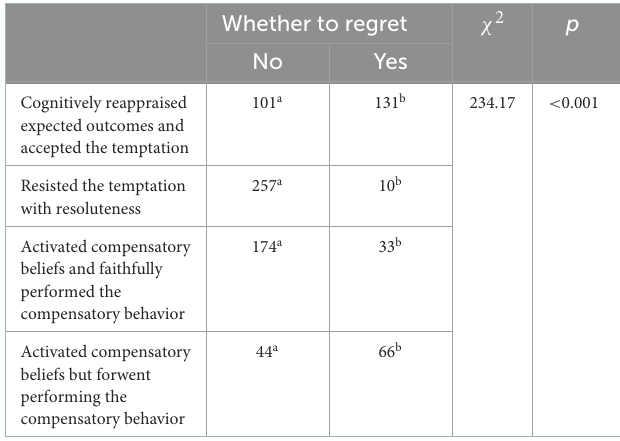
TABLE 2A Regrets of different options (college students).